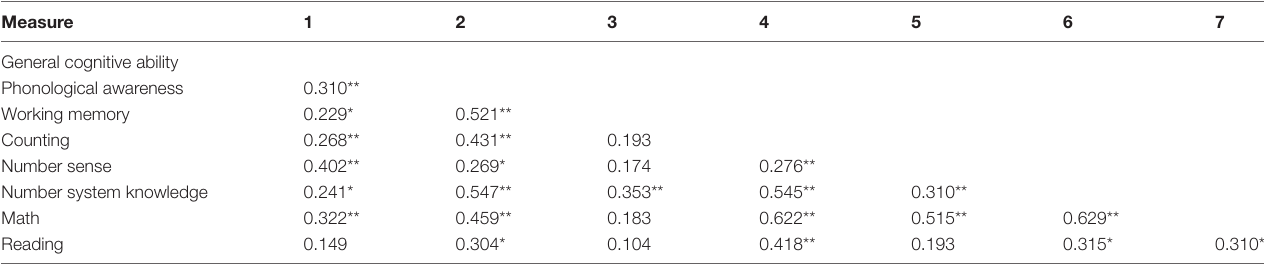
TABLE 2 | Pooled within-grade correlations among the